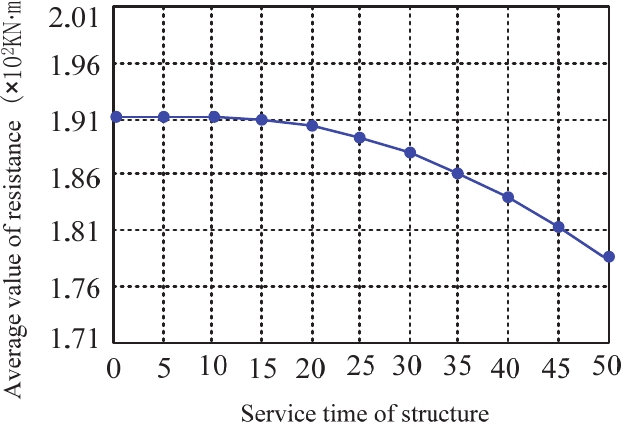
Figure 2. Time varying curve of average value of resistance.